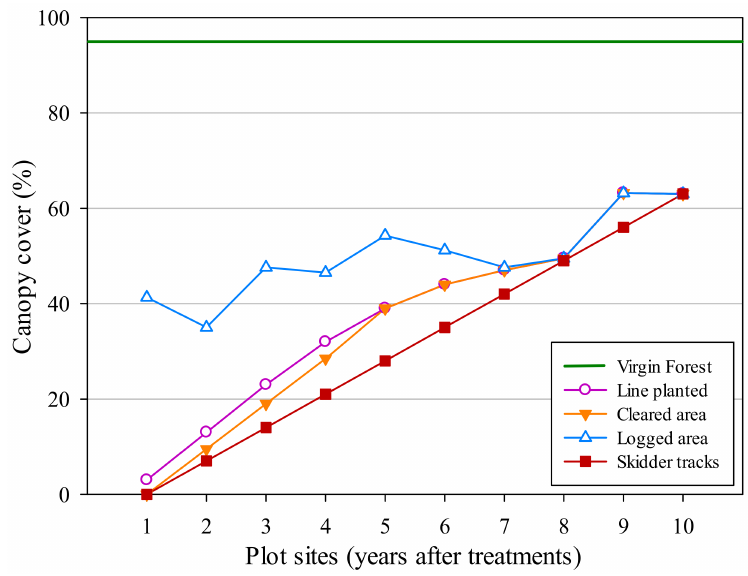
Figure 10. Canopy cover in the plot sites at different forestry